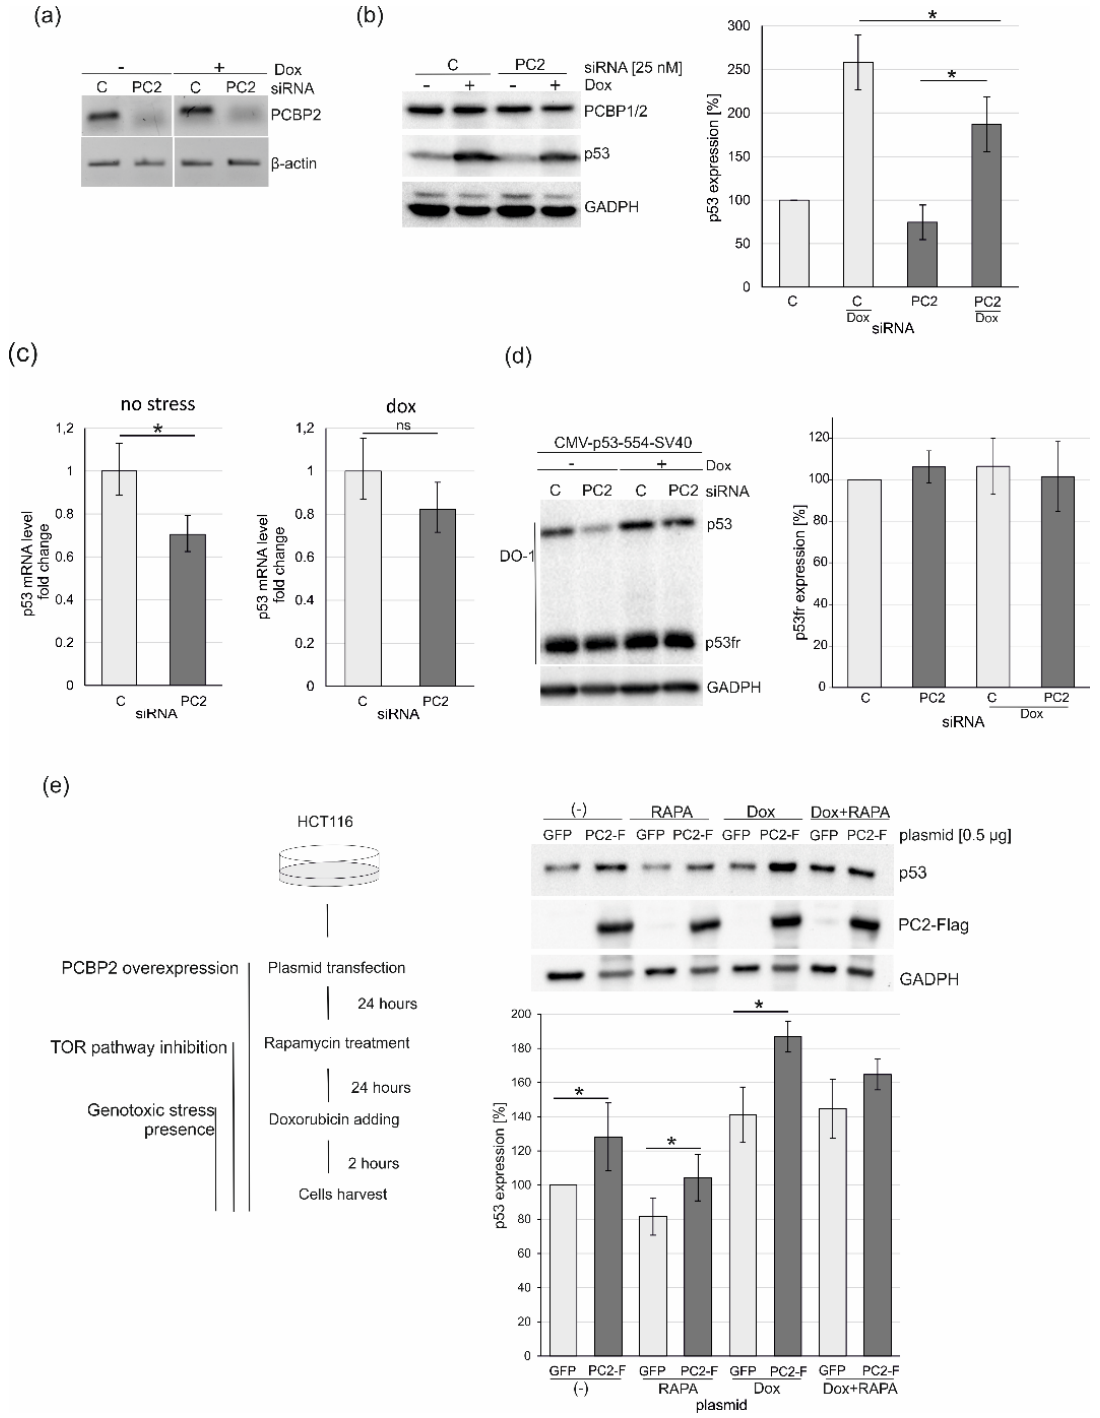
Figure 7. Changes in the p53 expression profile upon depletion or overexpression of PCBP2 in HCT116 cells. The cells were treated with specific PCBP2 or control siRNAs at the final concentration of 25 nM. Twenty-four hours after transfection the cells were exposed to doxorubicin (Dox, 0.5 μ g/mL) for 24 h and then harvested. All experiments were repeated at least three times. *— p -value < 0.05, calculated using Student’s t -test. ( a ) Downregulation of PCBP2 by siRNA was detected by RT-PCR. ( b ) The levels of p53, PCBP1/2 and GAPDH were determined by western blots. PCBP2 was detected using an antibody (hnRNP E1/E2) that recognised both isoforms PCBP1 and PCBP2. DO-1 antibody was applied to monitor p53 protein. The bar chart shows the p53 expression level under no stress and stress conditions (Dox) in the presence of a normal or reduced level of PCBP2. ( c ) Changes in the level of p53 mRNA under PCBP2 depletion. Expression of the TP53 gene at RNA level under no stress and stress conditions was quantified as described in the Materials and Methods section. ( d ) The C-truncated p53 protein (p53fr) expressed from a vector is not affected by PCBP2 downregulation. The cells were co-transfected by specific PCBP2 or control siRNAs at the final concentration of 25 nM together with 0.5 μ g of a vector (CMV-p53-554-SV40). Twenty-four hours after transfection, doxorubicin (Dox, 0.1 μ g/mL) was added for 24 h and then the cells were harvested. The bar chart shows p53fr protein level under normal and stress conditions in the